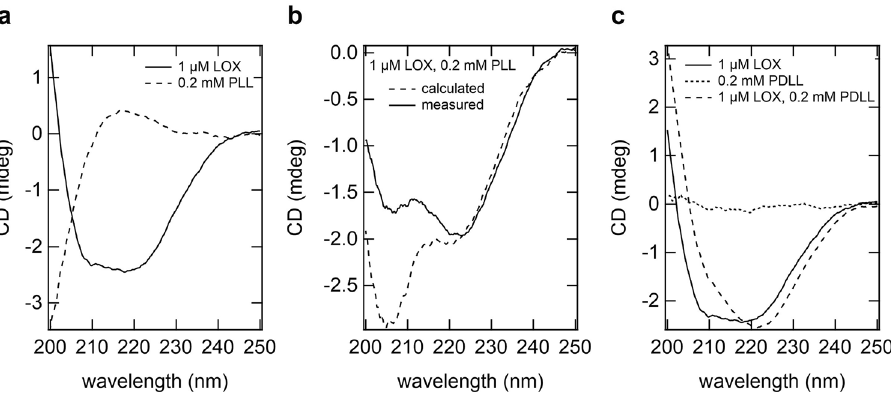
Figure 5. Far-UV CD spectra of LOX and PLL in clusters lox . ( a ) CD spectra of 1 μM LOX (solid line) and 0.2 mM PLL (broken line). ( b ) CD spectrum of LOX and PLL mixture (solid line), and CD spectrum calculated from that of LOX and PLL in A (broken line). ( c ) CD spectra of PDLL, LOX and LOX with